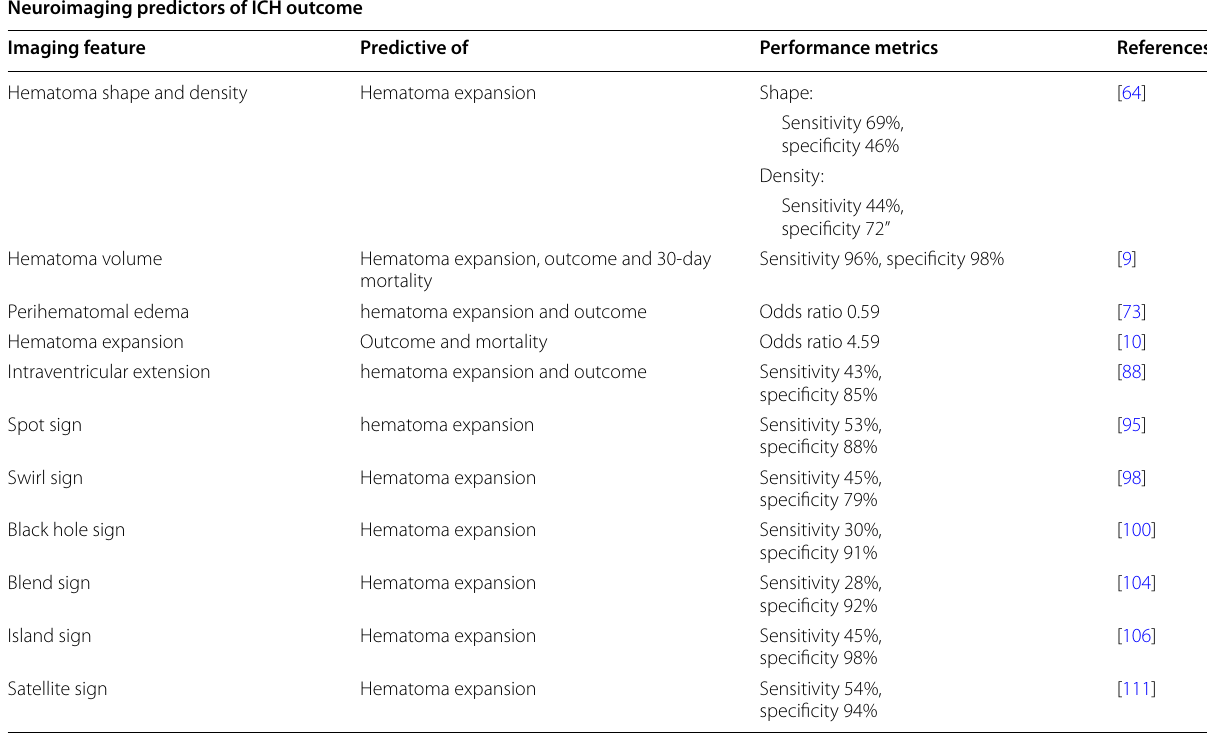
Table 5 Examples of the most common neuroimaging markers on NCCT (CTA for spot sign) relevant for outcome prognosticating and corresponding performance metrics and